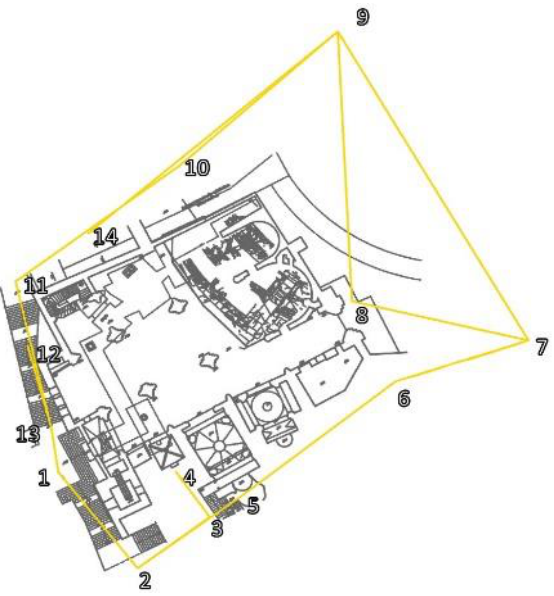
Figure 5. Location map of the 14